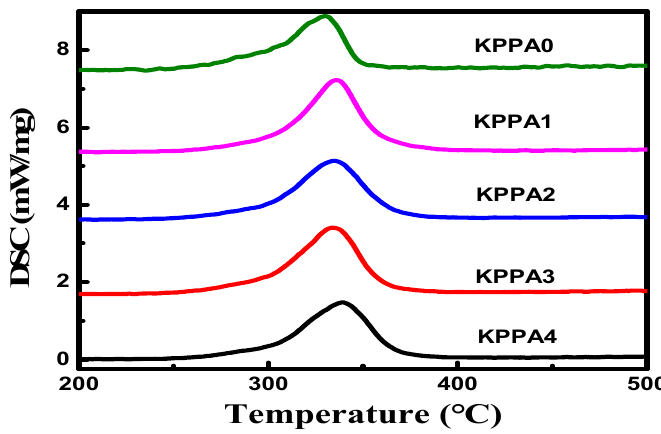
Figure 7. The DSC curve of the KPPA0, KPPA1, KPPA2, KPPA3 and KPPA4 cryogels.